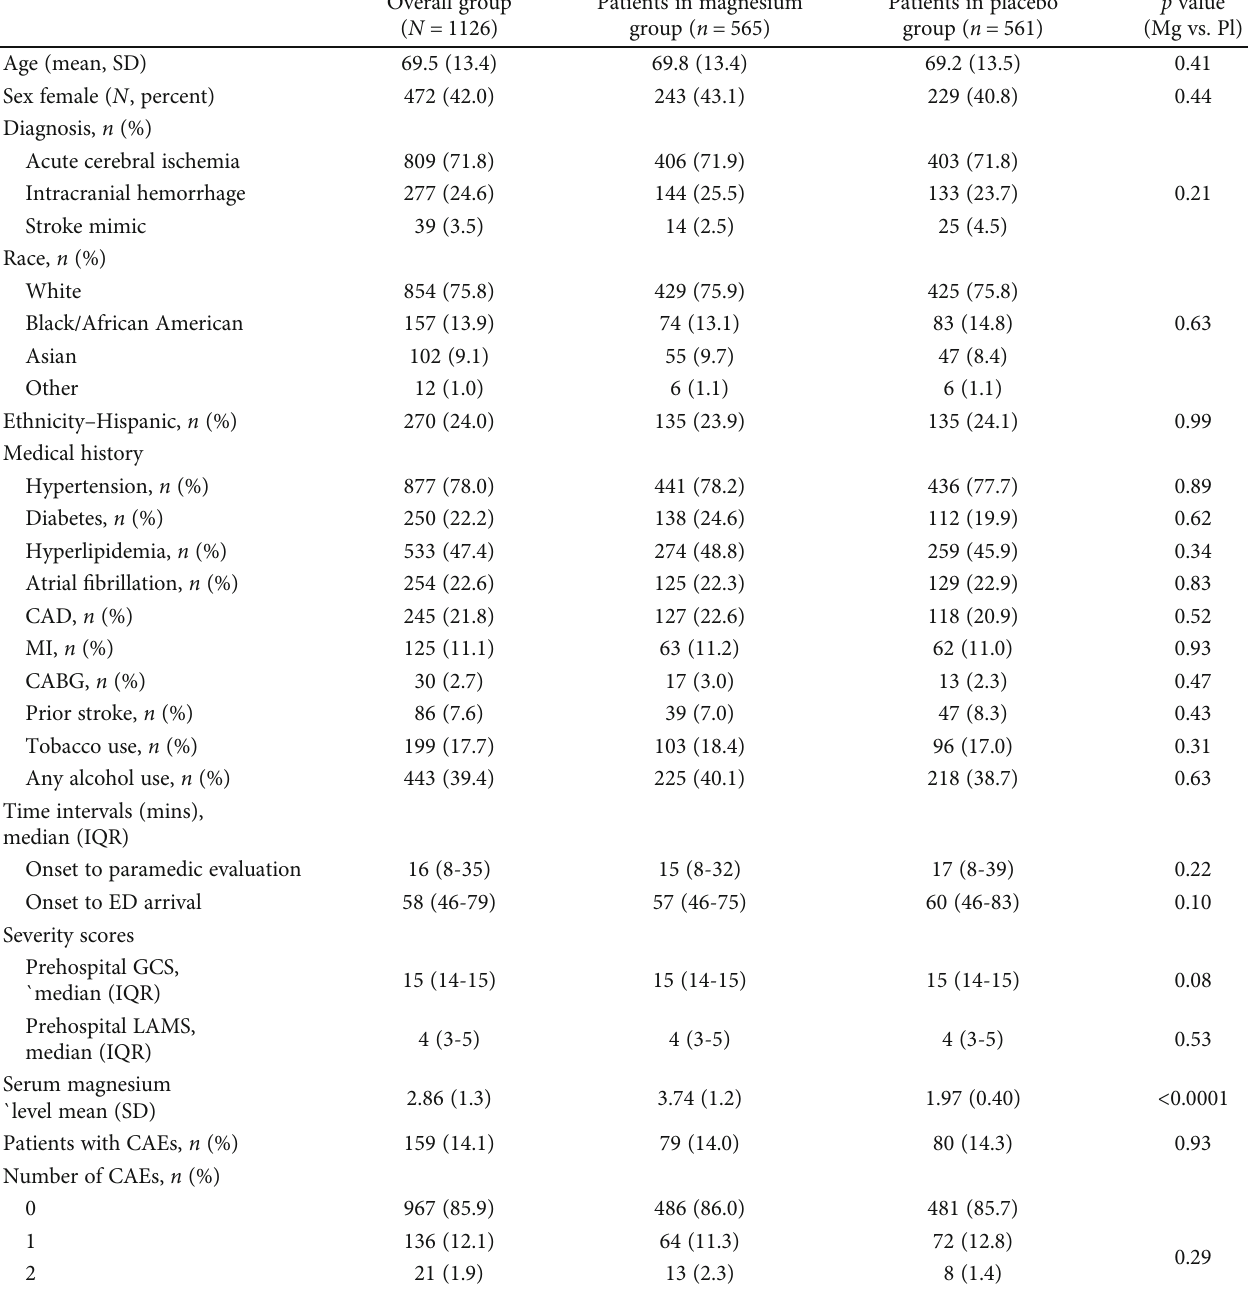
Table 1: Dichotomized demographic and clinical characteristics of patients in magnesium and placebo